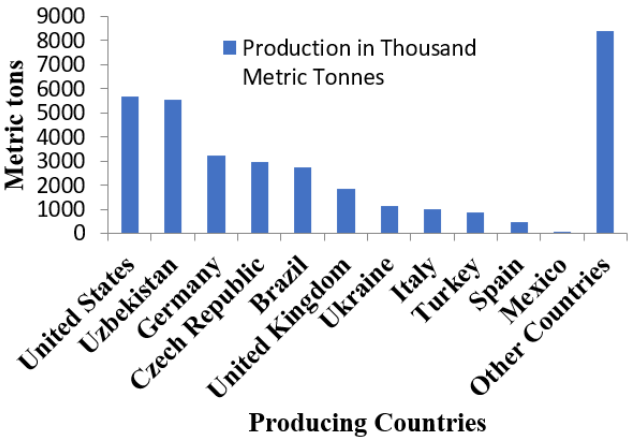
Figure 1. Major producers of